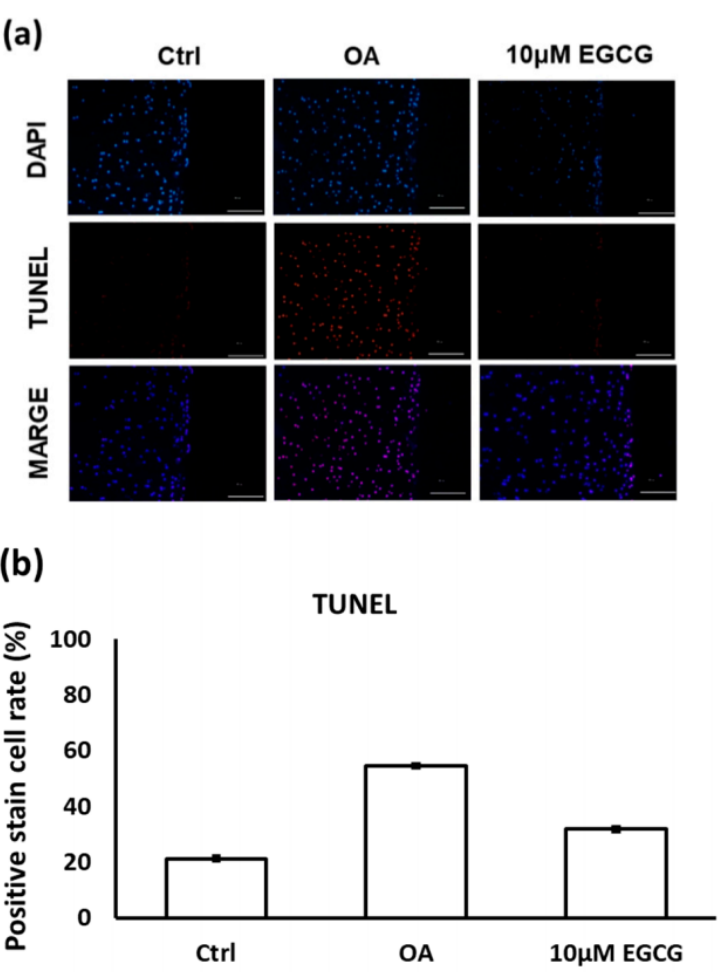
Figure 6. ( a ) The representative micrographs of TUNEL staining showing an increase of TUNEL- positive cells after osteoarthritis (OA) induction. Notably, fewer TUNEL-positive cells were observed in EGCG-treated OA joints. ( b ) Quantitative analysis of chondrocyte apoptosis in three groups. (** p < 0.01 OA vs. control; ## p < 0.01 OA vs.